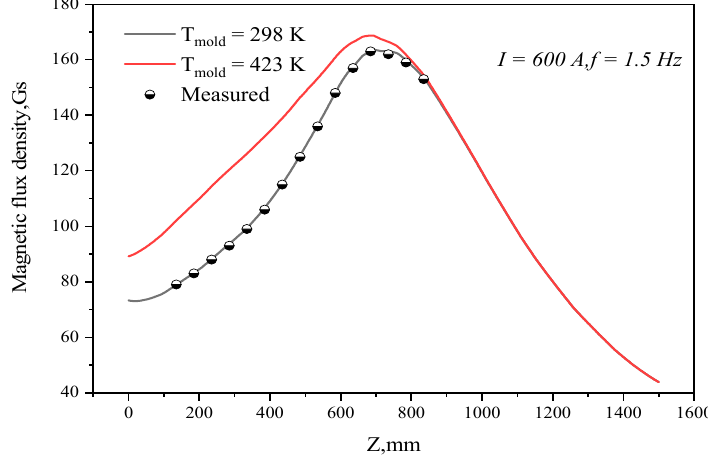
Figure 3. Comparison of the calculated and measured values for magnetic flux density.